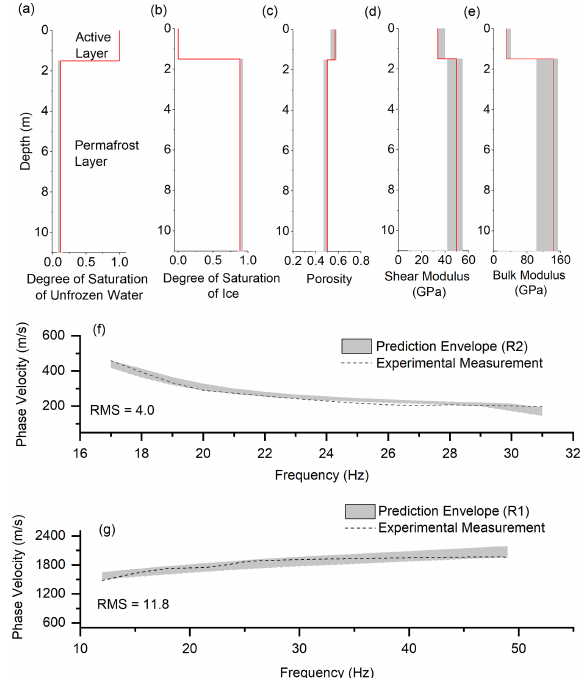
Figure B3. Surface wave inversion results for section 4 (from 360 to 480m). (a) Degree of saturation of unfrozen water, (b) degree of saturation of ice, (c) porosity distribution, (d) shear modulus of solid skeletal frame, (e) bulk modulus of solid skeletal frame, (f) experimental and numerical dispersion curves for the R2 wave, and (g) experimental and numerical dispersion curves for the R1 wave.